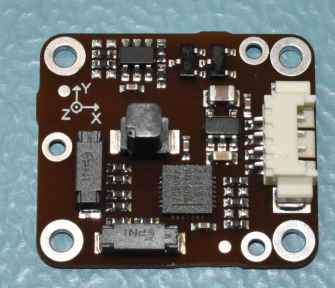
Figure 10. PNI RM3100 magnetometer. Photo courtesy of GOMSpace.